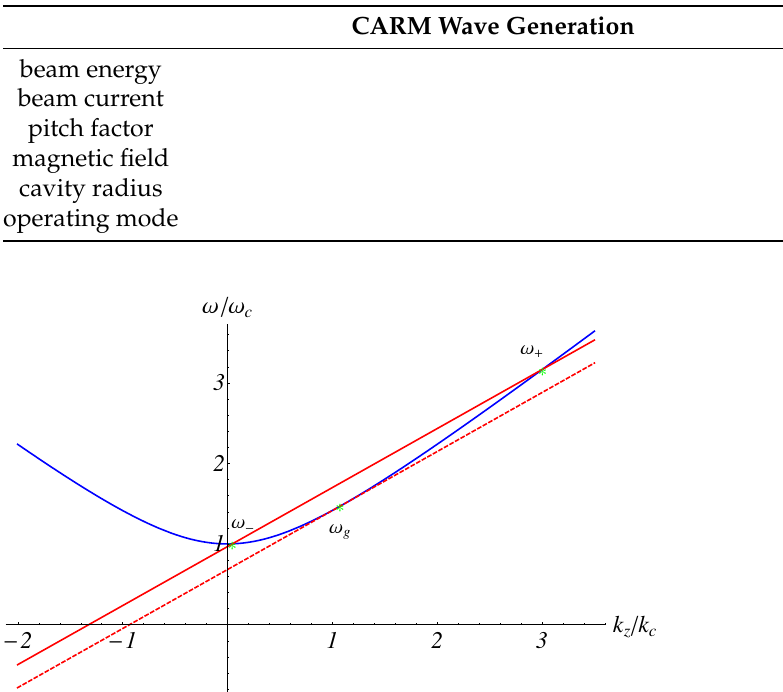
Table 1. Main parameters settings to generate a CARM RF wave at ≈ 150 GHz with output power of ≈ 5 MW.